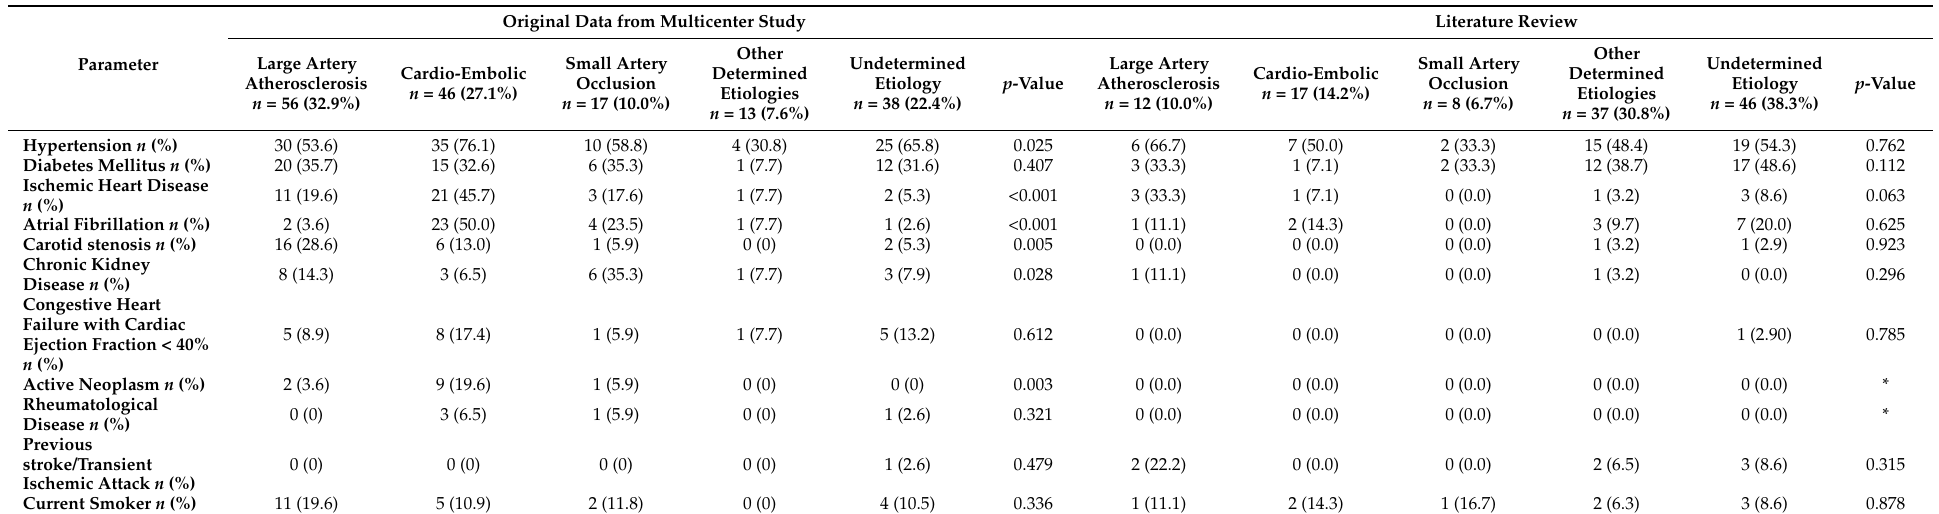
Table 3. The proportion of comorbidities under each subgroup of TOAST in original dataset and literature review dataset. Due to missingness, the valid percentages are reported in this